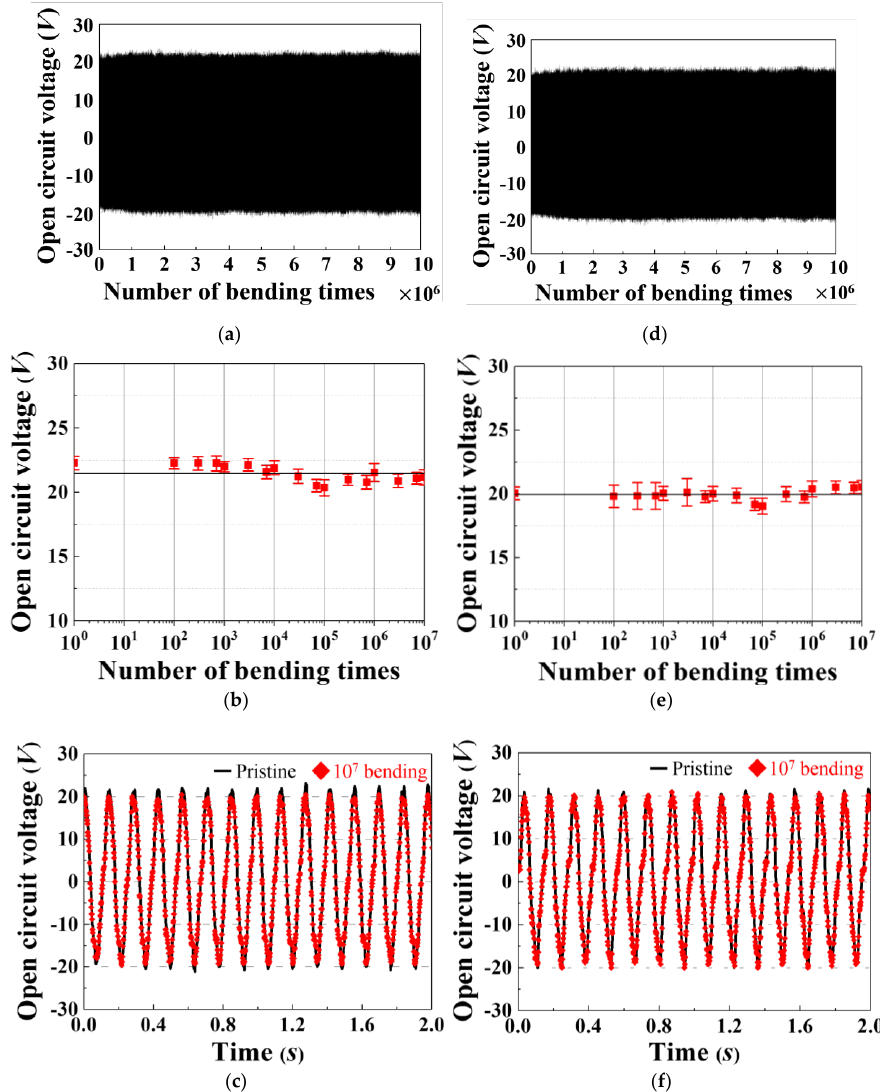
Figure 2. The measured open circuit voltages during repeated bending of 10 7 times ( a – c ) The open circuit voltage profile for tensed PVDF layers ( d – f ) those for compressed PVDF layers.